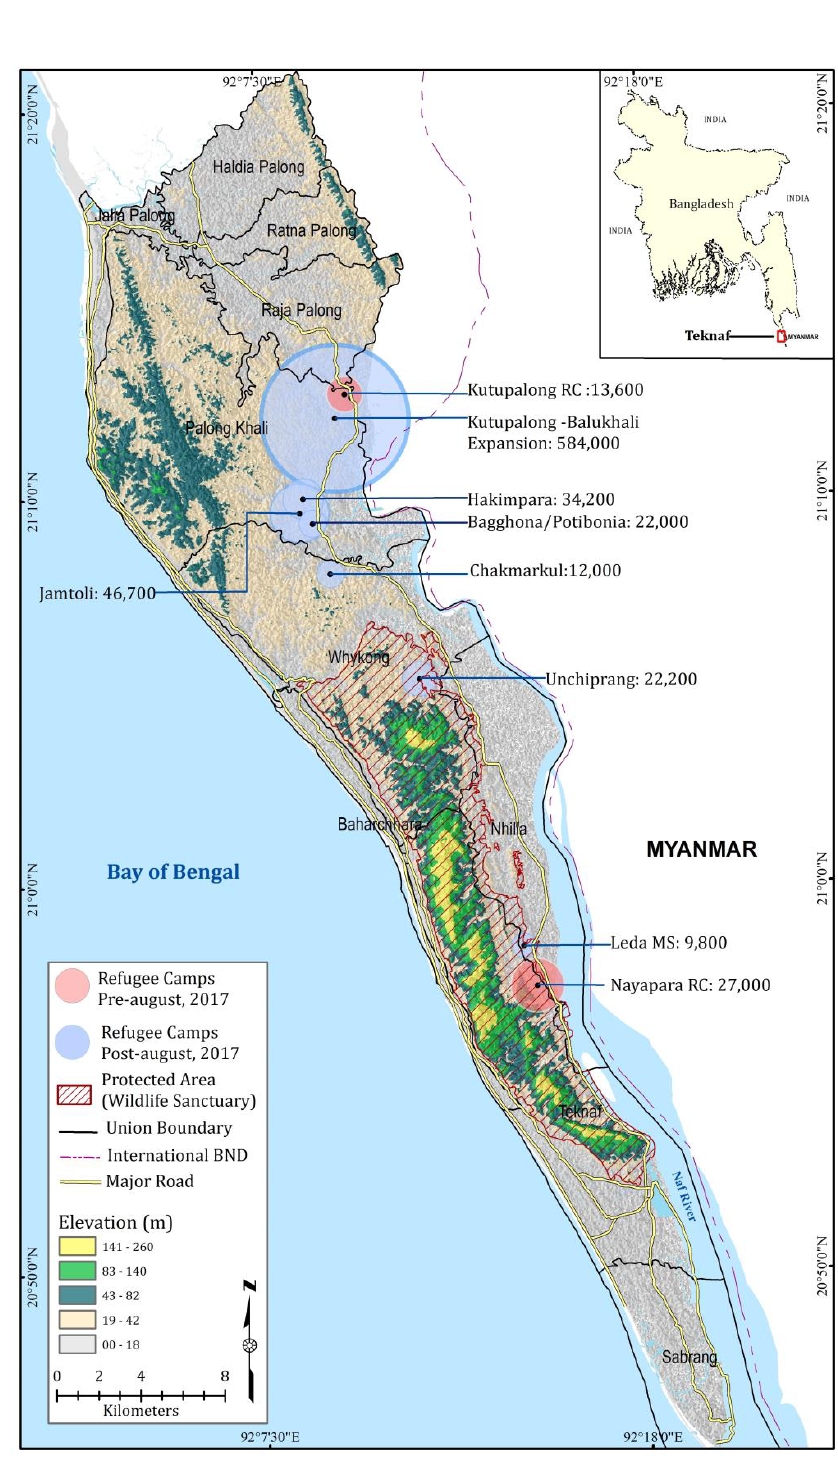
Figure 2. Location and elevation of the study area, including the geographical setting of each refugee camp with total refugee population as of 25 March 2018. The camps’ geographical locations and numbers of Rohingya refugees (circle size represents comparative population size of each area) in each camp were derived from Inter Sector Coordination Group (ISCG) [36]. The inset map (top right corner) shows Bangladesh with three sides; west, north and east, bordered by India and only a small border with Myanmar in the southeast where the study area, Teknaf, is located.